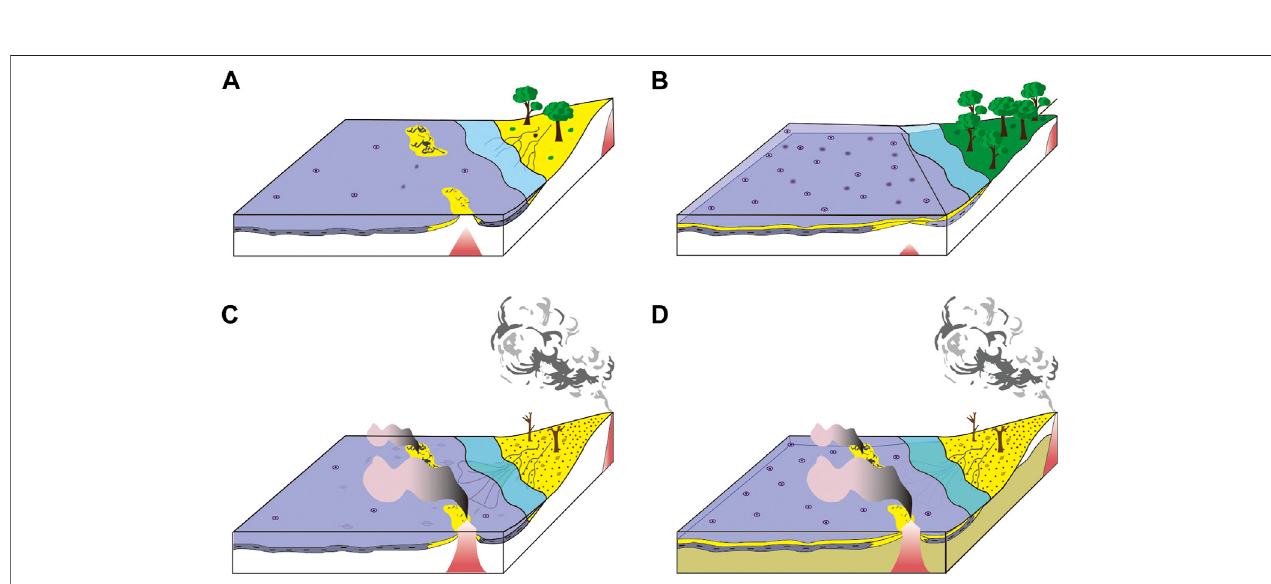
FIGURE 8 | Mechanism of a volcanic action on organic matter enrichment in a neritic carbonate platform environment. (A) Topographic rise, enhanced earthquakes,andmoreterrestrialinputsbeforeavolcaniceruption. (B) Synergisticallyincreasedoceanandlandproductivityafteravolcaniceruption. (C) Landplantsdie and consequently increase input of terrestrial organic matter in phase-I of a volcanic eruption. (D) Decreased input of terrestrial organic matter and remnant organisms, like algae, in phase-II of a volcanic eruption.